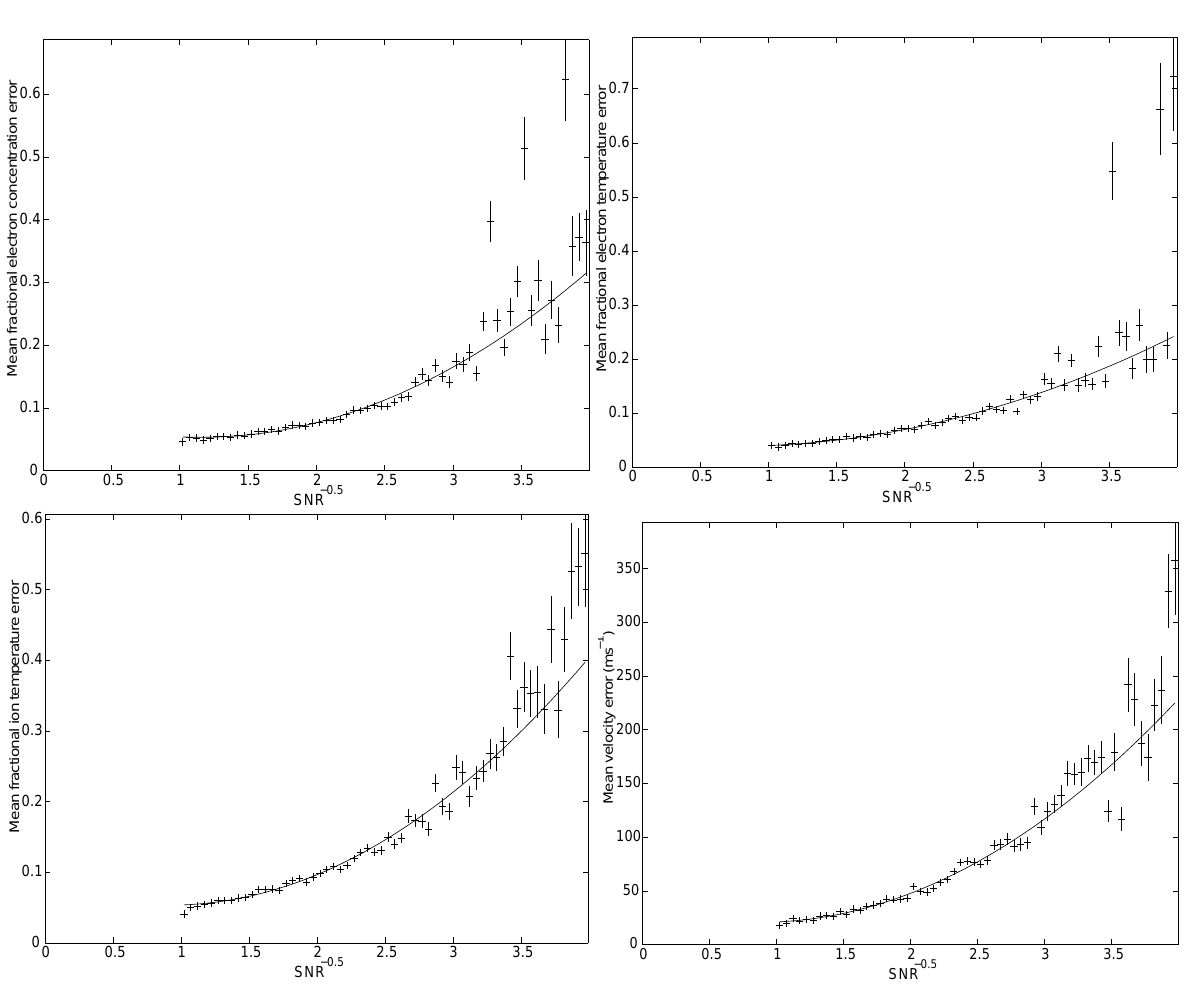
Fig. 1. Second-order polynomial fits to the uncertainty levels for the four main EISCAT parameters binned according to SNR − 0 . 5 for a sample frequency channel (1). The error bars represent the standard deviations of the distributions in each bin and are used to weight the fit. The four panels show the relative uncertainty in electron concentration, electron temperature, ion temperature, together with the uncertainty in line-of-sight